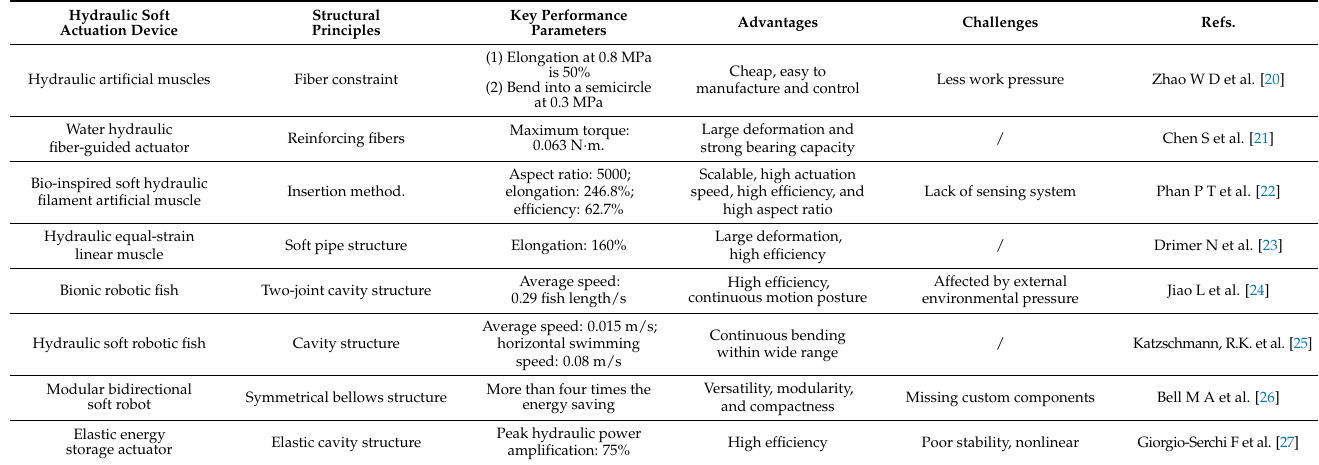
Table 1. Summary of hydraulic soft actuator based on mechanism research.